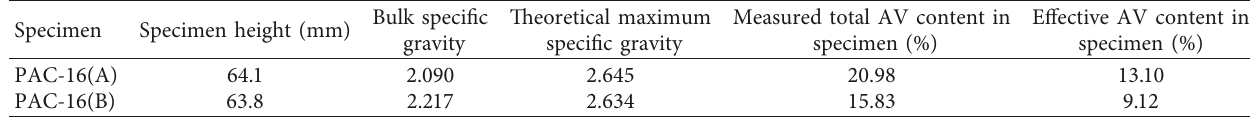
Table 2: Basic properties of the two PA